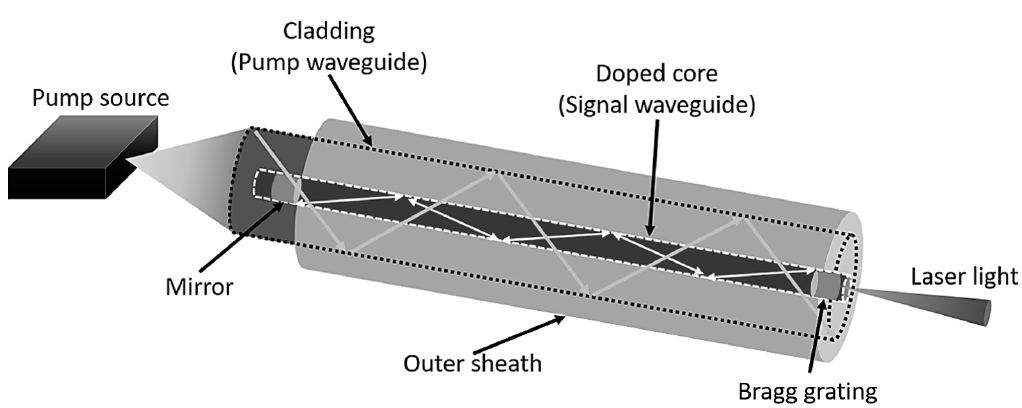
Figure 9. Schematic diagram of the fiber